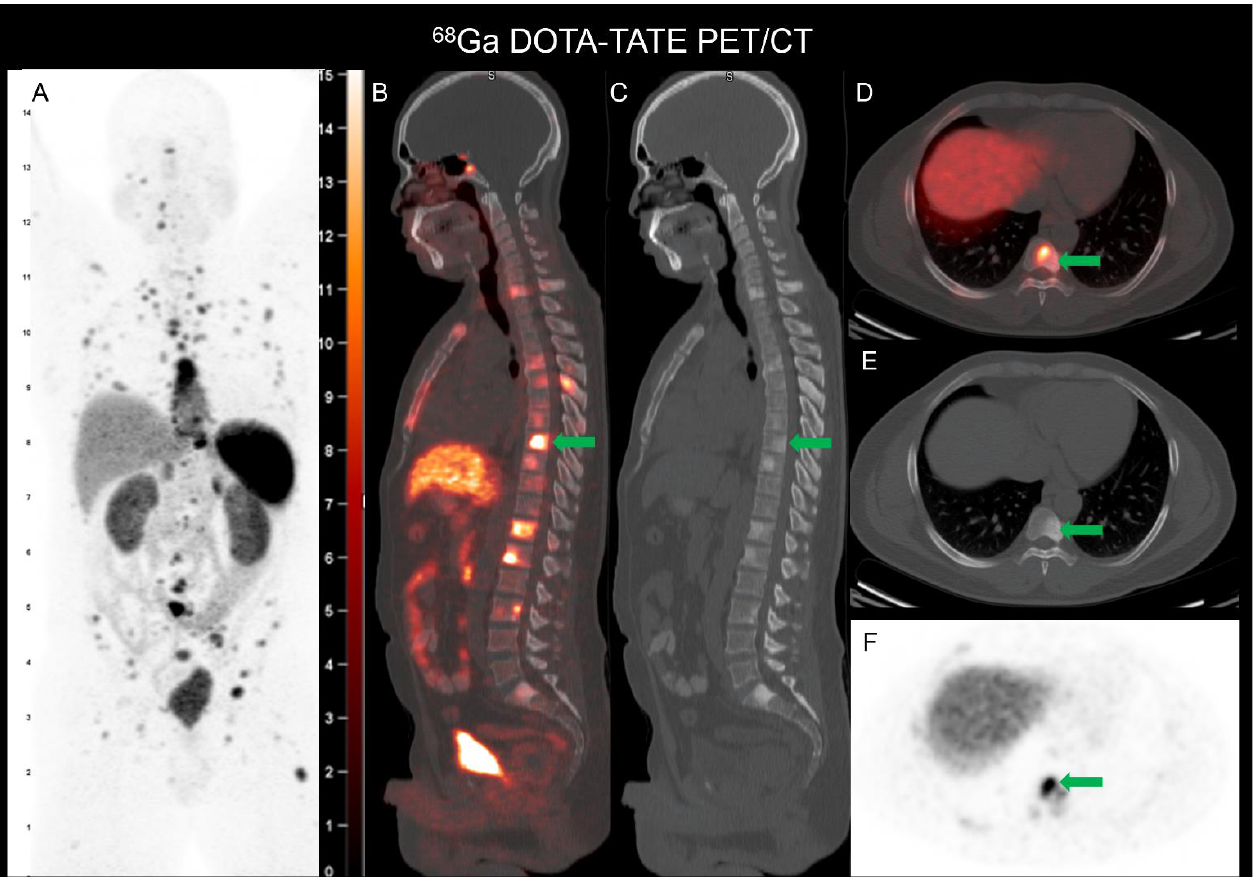
Figure 3. 68 Ga DOTATATE PET/CT evaluation of small cell neuroendocrine prostate carcinoma. Patient with Gleason score 5 + 4 = 9 mixed prostate small cell neuroendocrine carcinoma and acinar adenocarcinoma. Patient was started on ADT and cisplatin/etoposide prior to 68 Ga DOTATATE PET/CT. Anterior view of 68 Ga DOTATATE PET MIP ( A ) demonstrates multiple 68 Ga DOTATATE osseous and nodal metastatic deposits. Selected sagittal fused 68 Ga DOTATATE PET/CT ( B ) and CT ( C ) images show marked 68 Ga DOTATATE uptake greater than liver (SUVmax of 14.4) in several osseous lesions. Transaxial fused 68 Ga DOTATATE PET/CT ( D ) and CT ( E ) and PET ( F ) images show marked 68 Ga DOTATATE in the most avid T8 lesion having a SUVmax of 20.1 (green arrow). Patient did not demonstrate a PSA response to therapy and passed away 4 months after 68 Ga DOTATATE PET/CT.